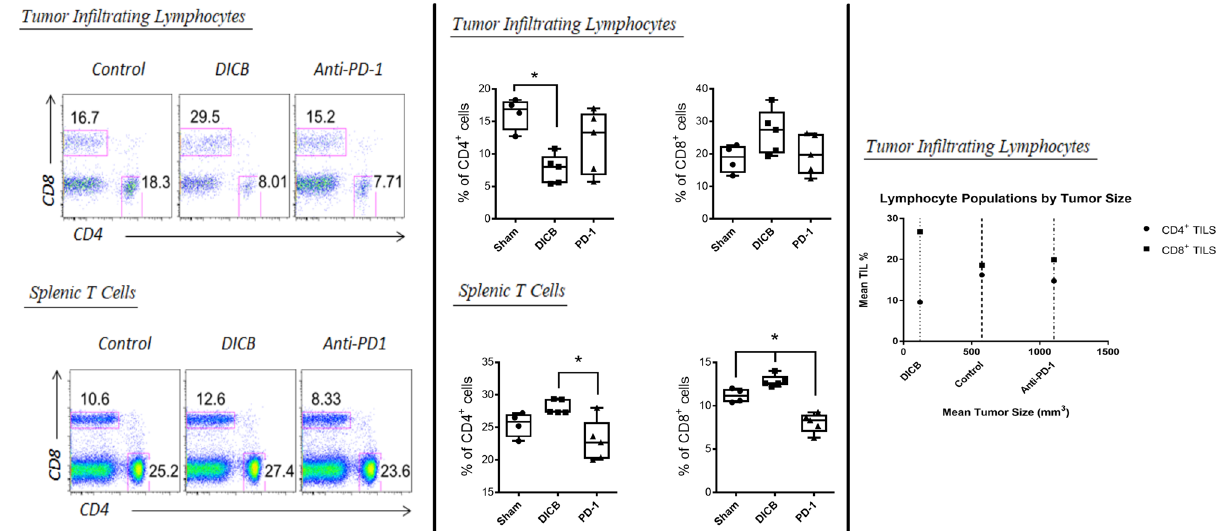
Figure 2. Flow cytometry analysis of tumor infiltrating and splenic CD4 + and CD8 + T cells divided into 3 panels. The first panel contains scatter graphs depicting the populations of CD4 + and CD8 + TILs/Splenic T cells for each trteatment group. The second panel shows box and whisker plots illustrating this same data with annotations of significance and the final panel shows the mean percentage of CD4 + versus CD8 + TILs by tumor size. Significance of p < 0.05 is denoted with an